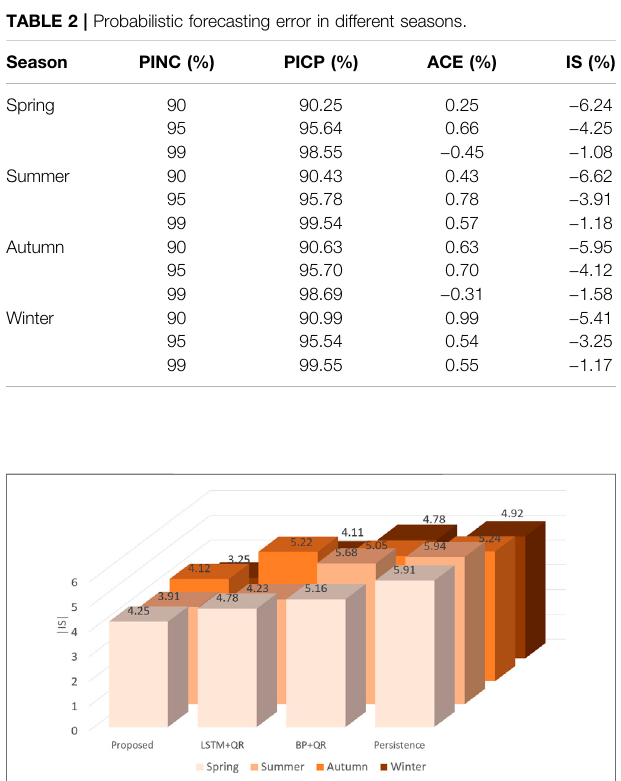
FIGURE 14 | IS performance with PINC 95%.